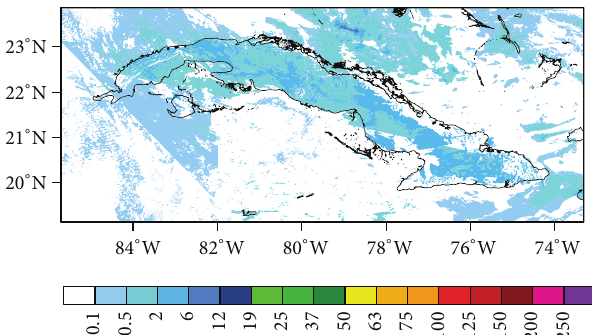
Figure 11: One-hour cumulative precipitation (mm) for NSAS Eta experiment. Valid for 2000 UTC, 1 May